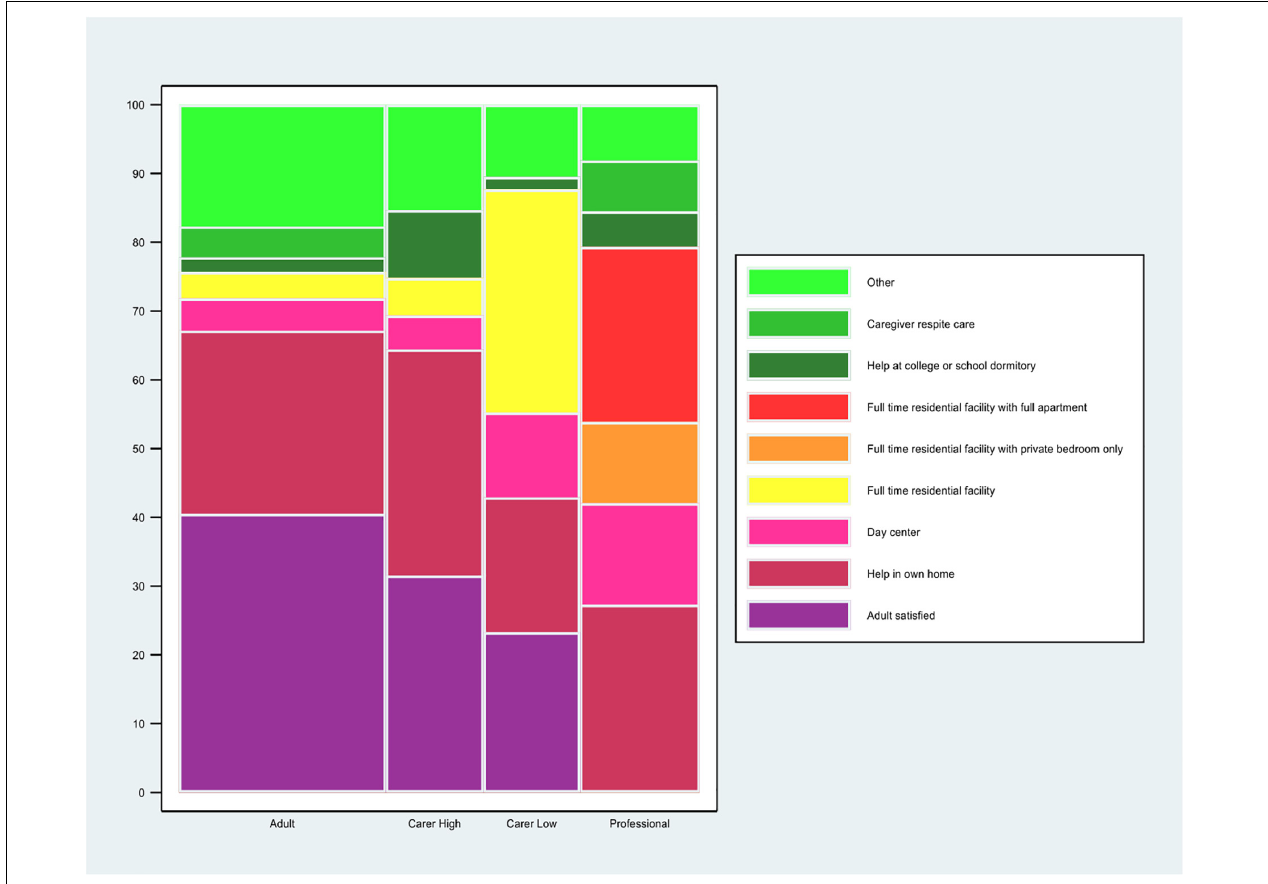
FIGURE 2 | Preferred residential service. The question for the autistic adults was: “ If you could choose a residential service that fits your needs best now, what would you choose? (Please, tick 1 box).” The question for the carers of autistic adults was: “If you could choose a residential service that fits the adult’s needs best now, what would you choose? (Please, tick 1 box).” The carers’ data are stratified by high and low level of independence of the autistic adult. The question for the professional was: “Which 2 types of residential services do you think are most needed for autistic adults in the (geographical) area where you work now? (Please, tick 2 boxes).” Professionals who selected “ I prefer not to make a choice ” are not included in the calculation of % for each of the other answer choices. The %s for the other answer choices are based on the professionals who made a choice, n = 271 (301–30 = 271). *This% is calculated on the total sample of the professionals’ responders ( n = 301). Data are for all adults and carers of